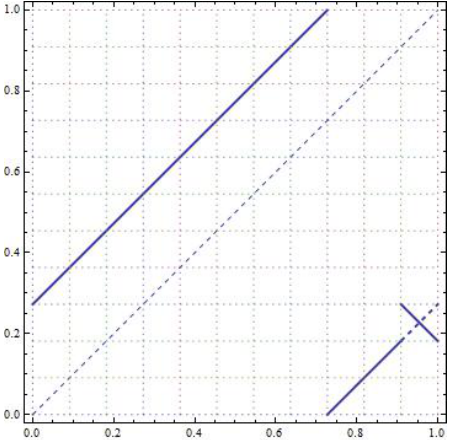
Figure 11. The graph of a ( 3,1 ) -IET with permutation ( 3,1, − 2 ) and λ = ( 8,2, 1 ) . The dotted line in interval I 3 is the graph of the rotation R